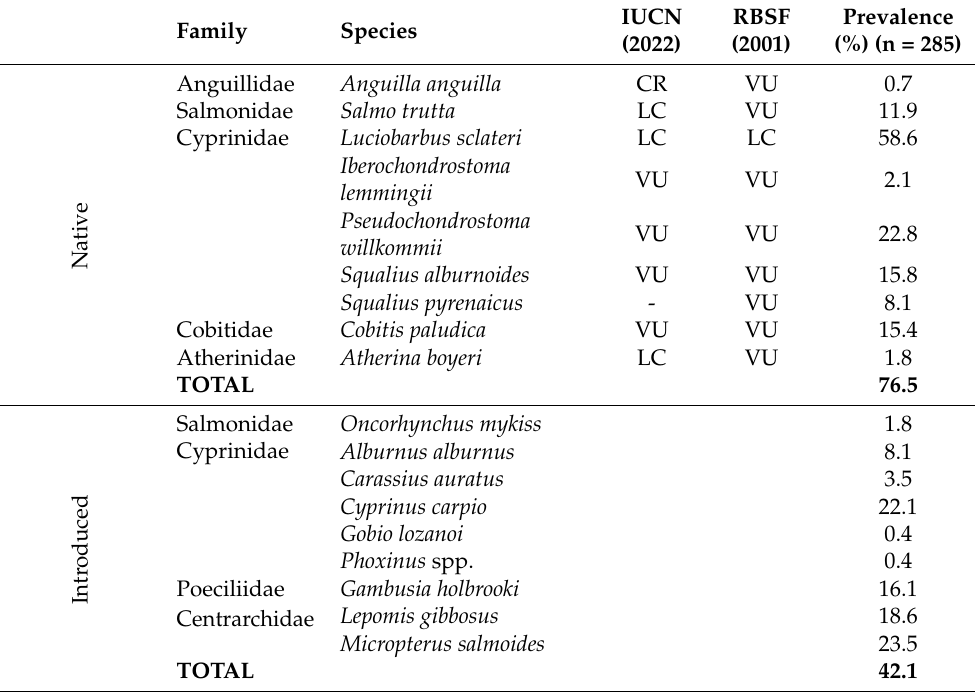
Table 3. List of native and exotic freshwater fishes detected during the field sampling. Threat categories are referred to IUCN Red List [10] and Red book of Spanish freshwater fish, RBSF [20]. CR: Critically endangered; EN: endangered; VU: vulnerable; LC: least